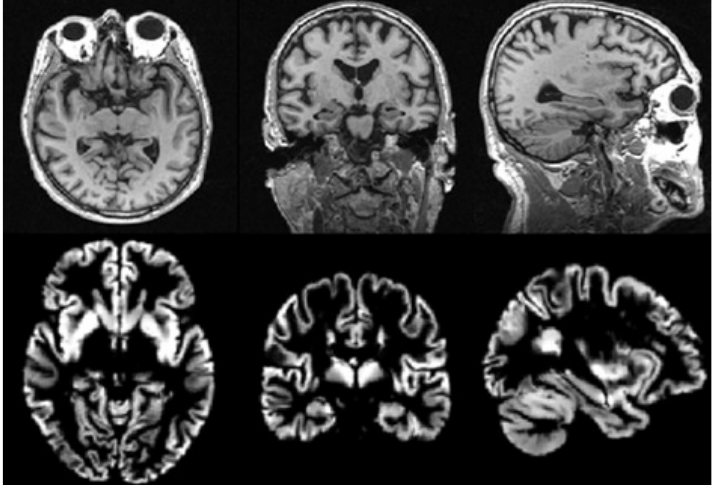
Figure 2. Images before and after preprocessing: The first row shows the original images, and the second row shows the final gray matter